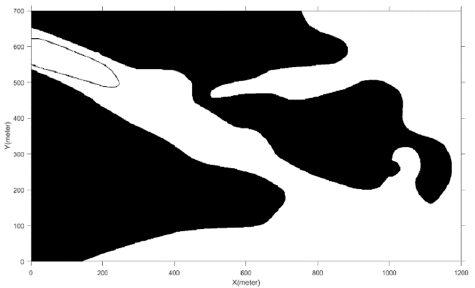
Figure 3. Marine environmental information extraction and processing.